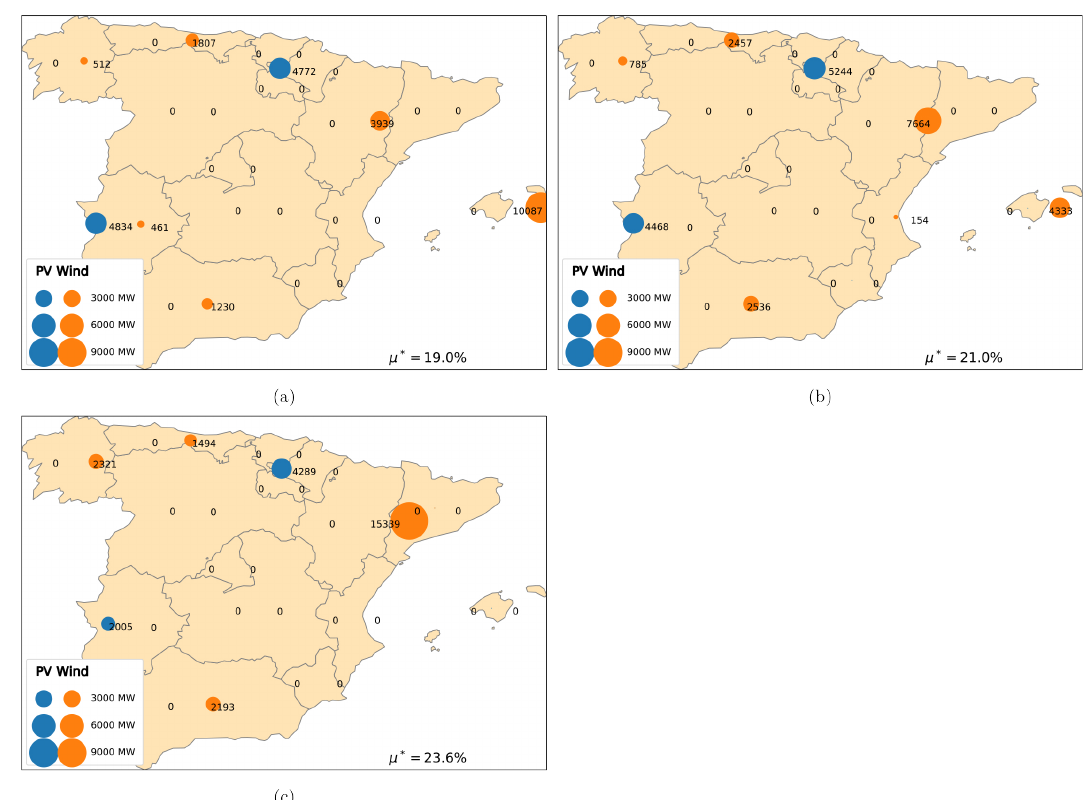
Figure 8. NEW/CAL ( a ) penetration-risk diagram and ( b ) high-penetration mix.